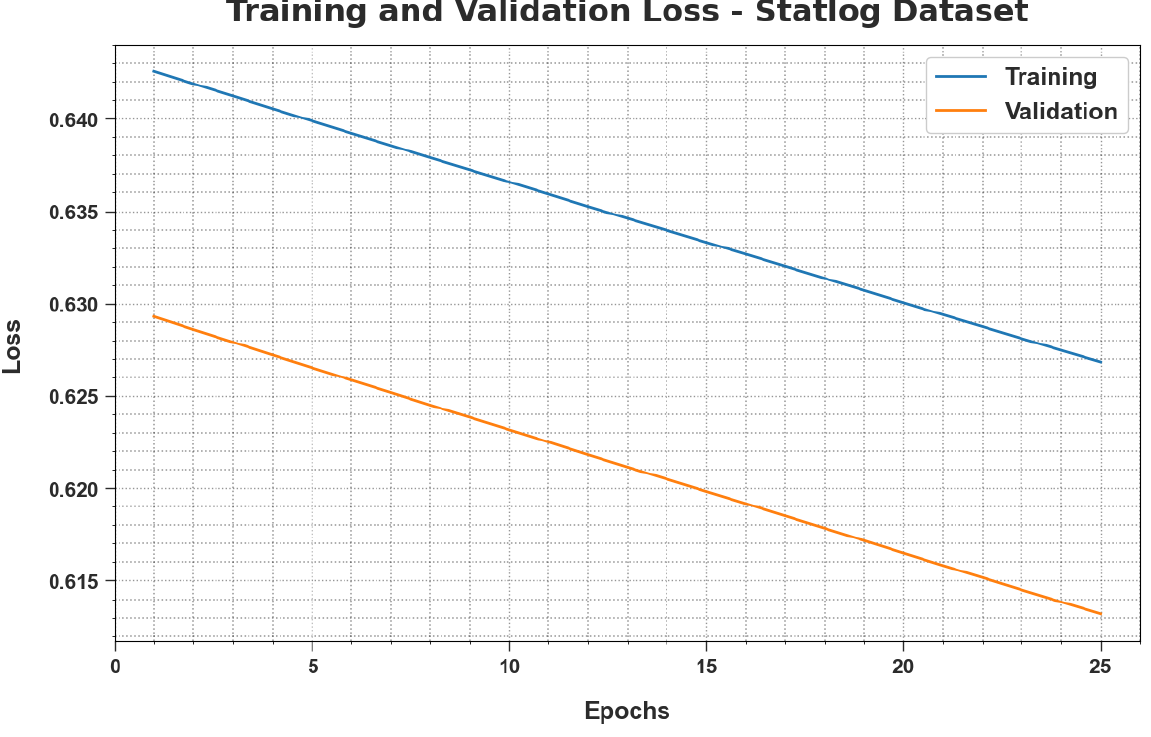
Figure 11. 𝑇𝑅 𝑙𝑜𝑠𝑠 and 𝑉𝐿 𝑙𝑜𝑠𝑠 analyses results of the MLMDMC-ED algorithm on the Figure 11. TR loss and VL loss analyses results of the MLMDMC-ED algorithm on the Statlog Statlog dataset.